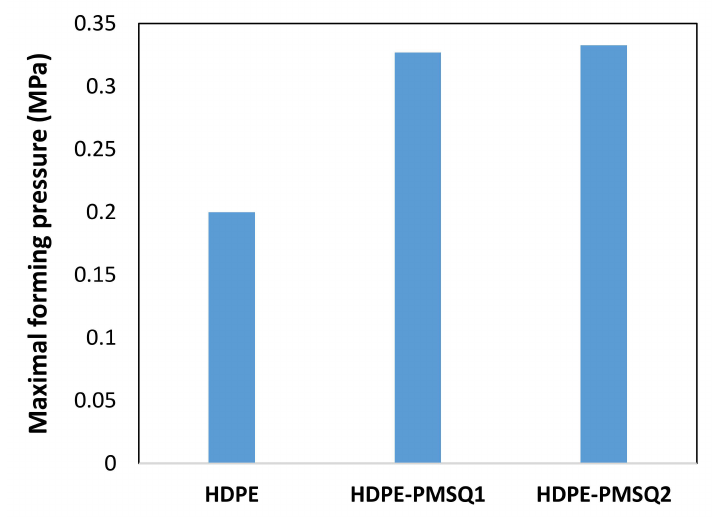
Figure 9. Maxima internal pressure